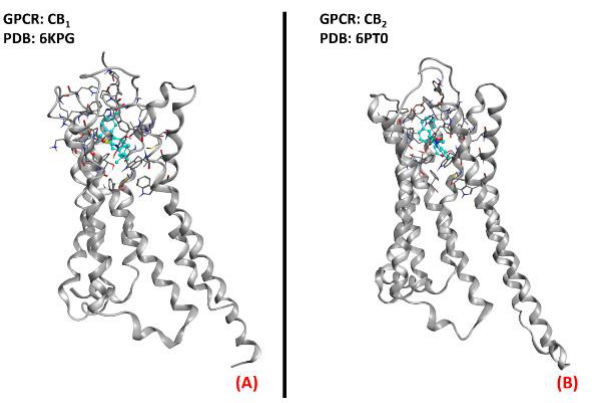
Figure 21. The structures of ( A ) the CB 1 receptor (sourced from the Protein Data Bank, PDB code: 6KPG [137], method: cryo-EM, resolution: 3.00 Å) and ( B ) the CB 2 receptor (sourced from the Protein Data Bank, PDB code: 6PT0 [138], method: cryo-EM, resolution: 3.20 Å). The images were created and rendered with MOE.